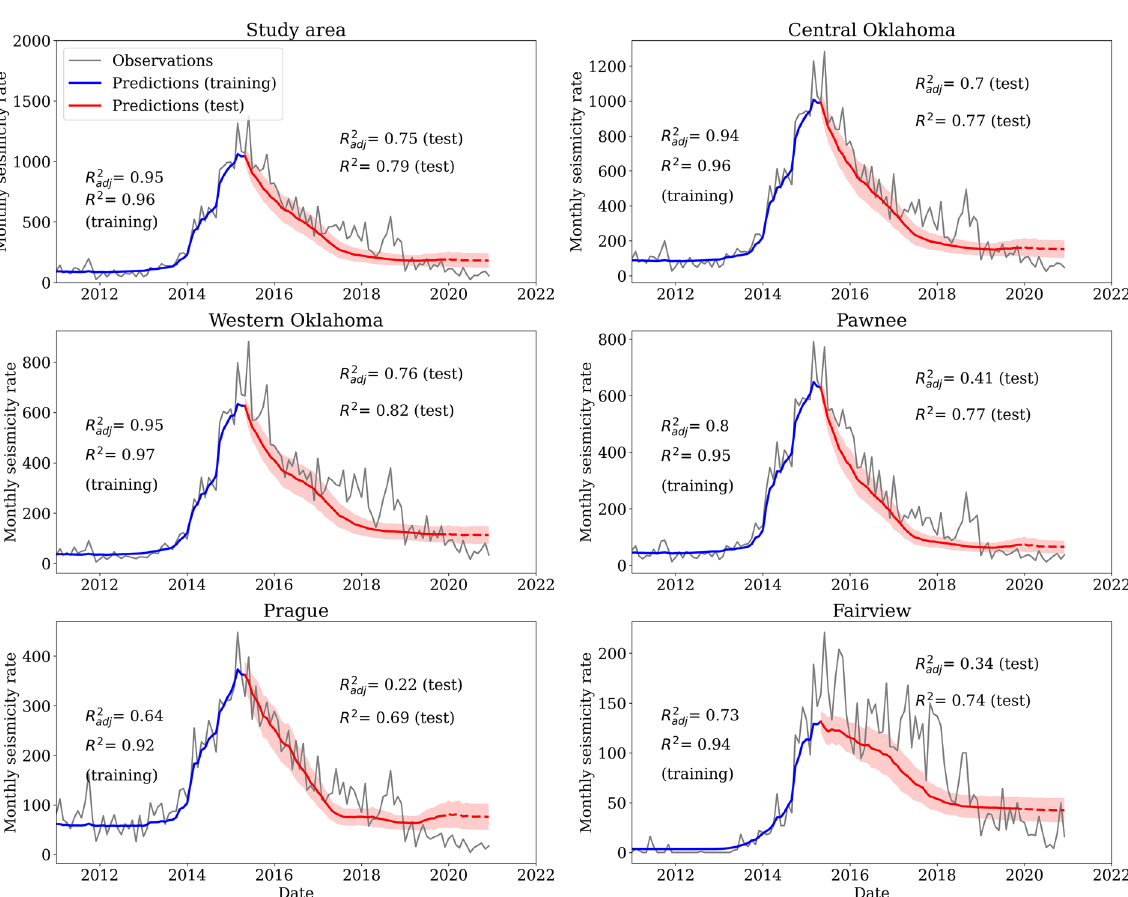
Figure 3. Seismicity rate forecast for different regions, including the whole study area, central Oklahoma (longitude ≥ − 98 ◦ ), western Oklahoma (longitude < − 98 ◦ ), Pawnee area, Prague area, and Fairview area. The gray lines are observations, and the blue and red lines are forecast results from training and test dataset, respectively. The red dashed line shows forecast for year 2020, where the injection data are not available yet. Red areas indicate one standard deviation from 100 runs. The location of the Pawnee, Prague, and Fairview is shown 2 2 in Fig. 1. The R and R adj for training data and test data are listed on each subplot. Notice that 2 than R , especially for Pawnee, Prague, and Fairview, where the number of data points is